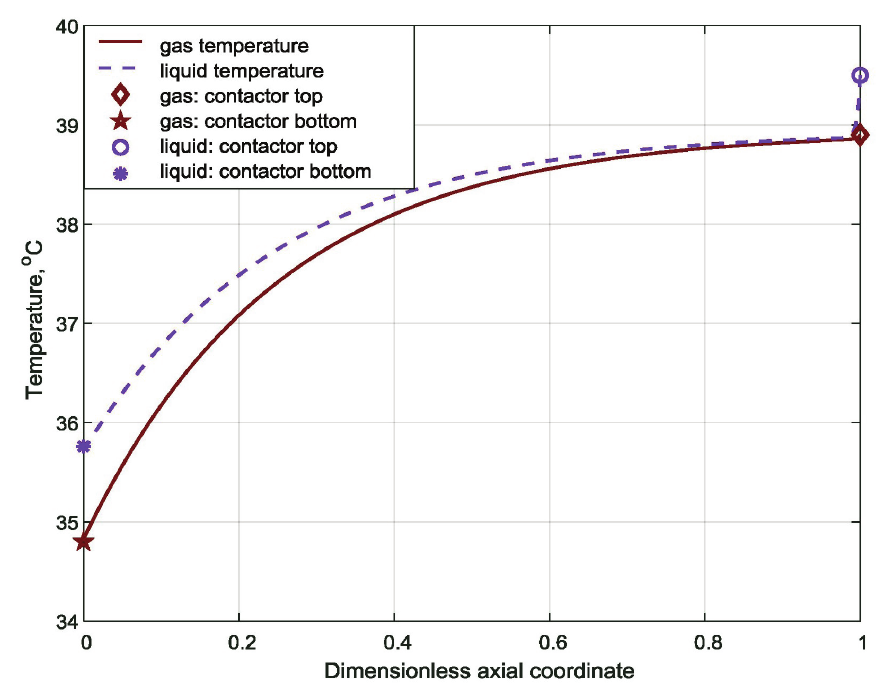
Fig. 6b – Example 1. Gas and liquid temperature profiles